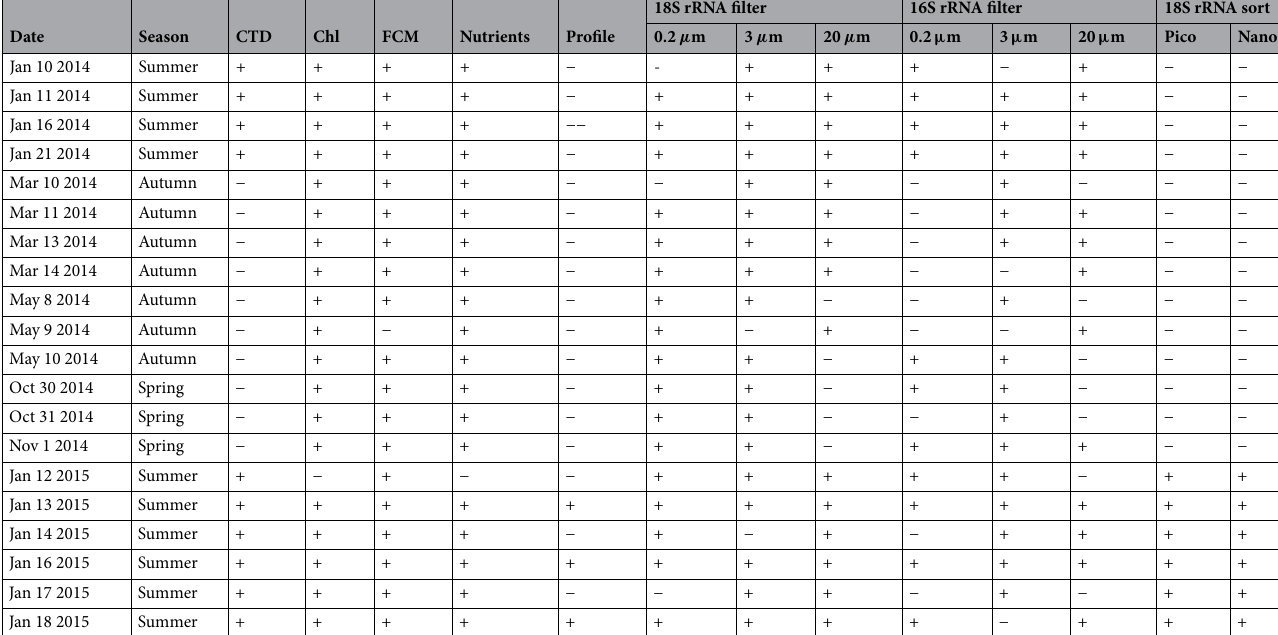
Table 1. Samples collected. CTD corresponds to salinity and temperature data from CTD cast, Chl to Chlorophyll a , FCM to flow cytometry and Profile to vertical profile sampling. 18S and 16S rRNA columns correspond to metabarcoding analyses for nuclear 18S and plastidial 16S rRNA gene. Crosses correspond to samples that were collected while the minus signs correspond to missing samples.